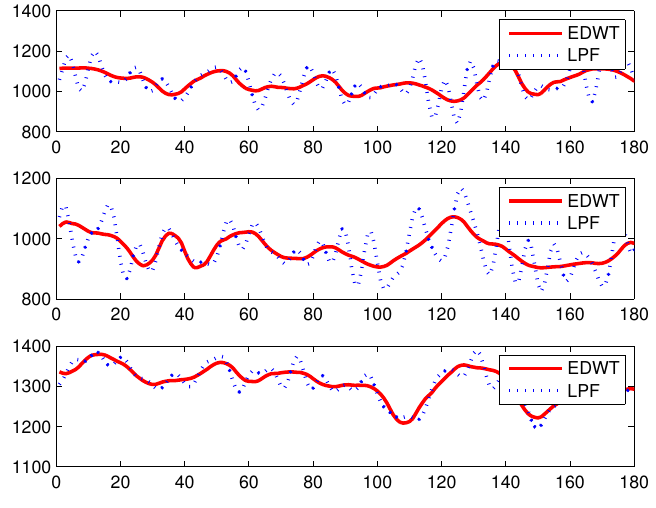
Figure 8. Actual measurements of gravity components along three axes. Using the measurements, we cannot obtain accurate parameters due to multiple sources of noise. From Figure 8 we can see that the original measurements curve has a large fluctuation range with noise, and signals along the x -axis are damaged by noises worst. Figure 9 shows the filtered signals along x , y , z axis respectively acquired by our pro- posed method as well as LPF, where high-frequency noises are eliminated. The processed data along x axis has been obtained, and we can even see its peak is at 40 s. For the signals along the y axis, there is a peak at around 120 s. This is because there is a severe trough in the original curve as shown in Figure 8, and the signals are recovered using the proposed method when we reconstruct signals based on (9).